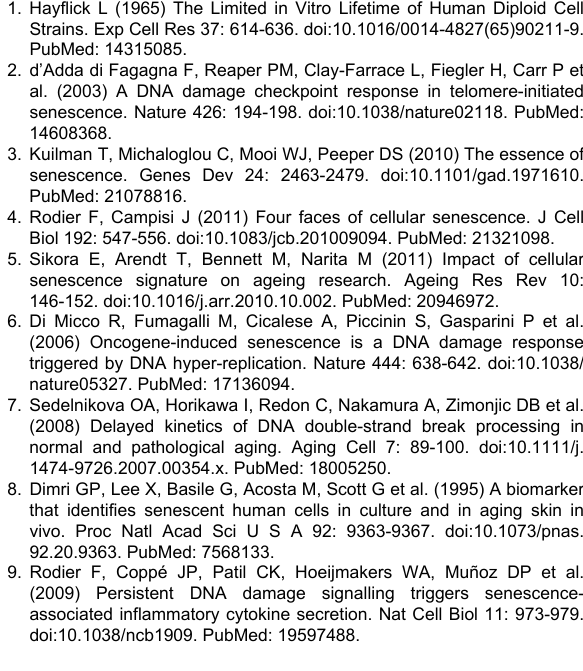
Figure S3. Senescent pks + E. coli infected IMR-90 cells promote the growth of bystander A-549 and HCT-116 p53 -/- tumour cells